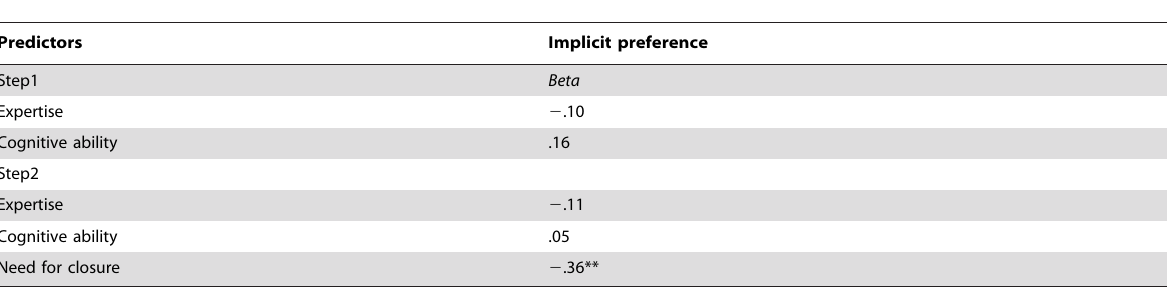
Table 3. Study one: Results of the hierarchical regression analysis.